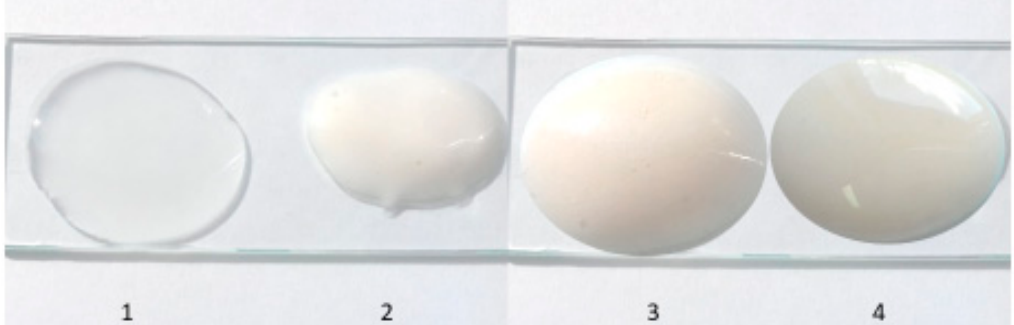
Figure 1. Macroscopic image of the hydrogel ointment and prepared ointments with ACTH: 1- ointment, 2-Glycerol ointment with ACTH 15 mg / g (F-9), 3-Glycerol ointment with ACTH 20 mg / g Glycerol ointment, 2-Glycerol ointment with ACTH 15 mg/g (F-9), 3-Glycerol ointment with ACTH (F-8) and 4-Glycerol ointment with ACTH 25 mg / g (F-7). 20 mg/g (F-8) and 4-Glycerol ointment with ACTH 25 mg/g (F-7).